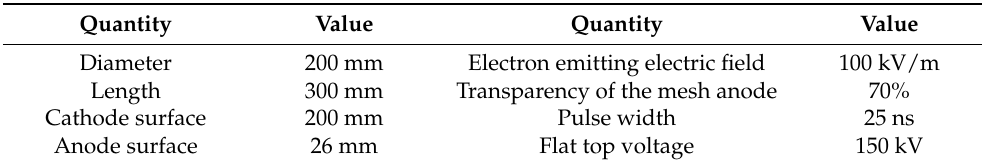
Table 2. Design parameters of the 10-stage PFN-Marx generator. Quantity Value Quantity Value